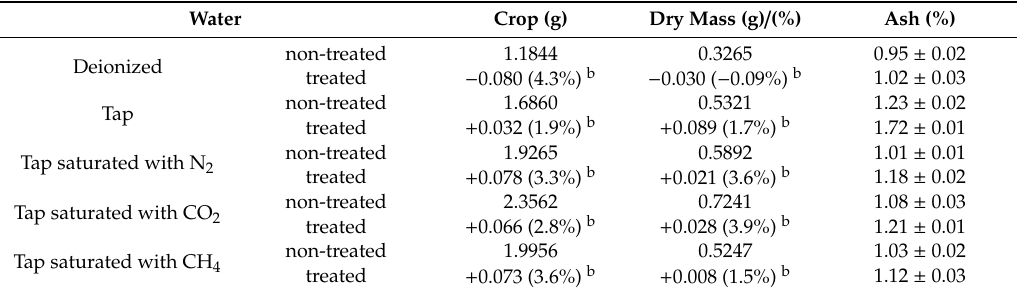
Table 1. E ff ect of the low-temperature, low-pressure glow plasma of low frequency (LPGP)-treated water on the yield of cress crops a .